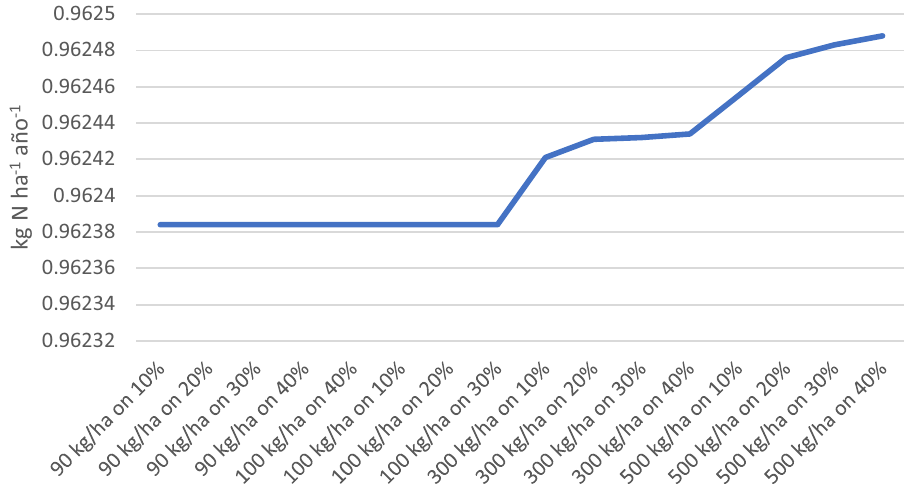
Fig. 11 Maximum export of nutrients to the Gulf of Batabanó for each of the treat-